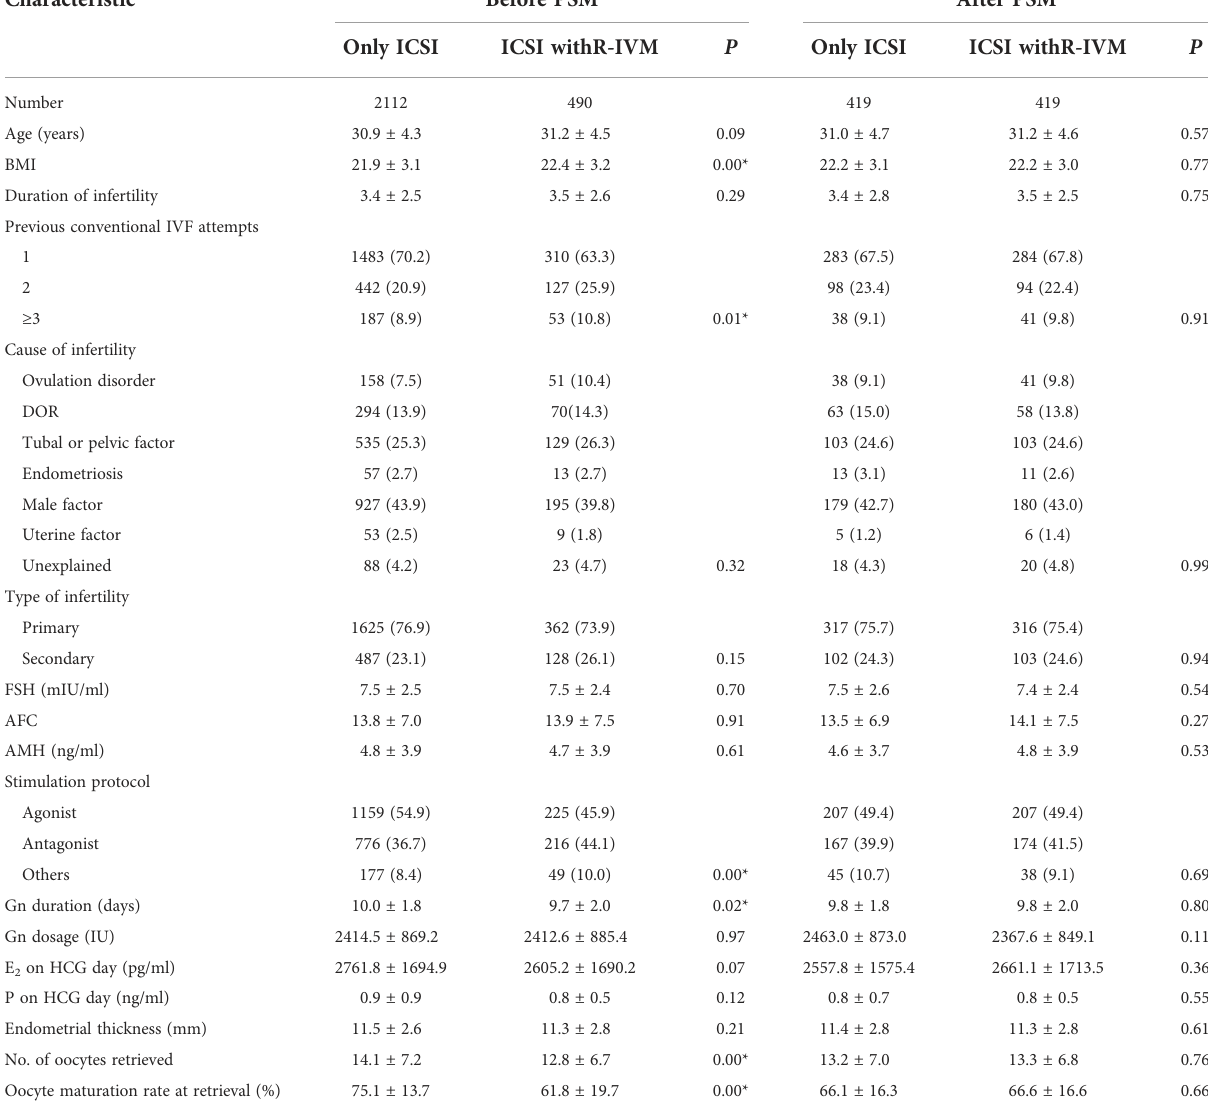
TABLE 1 Patient characteristics before and after propensity score